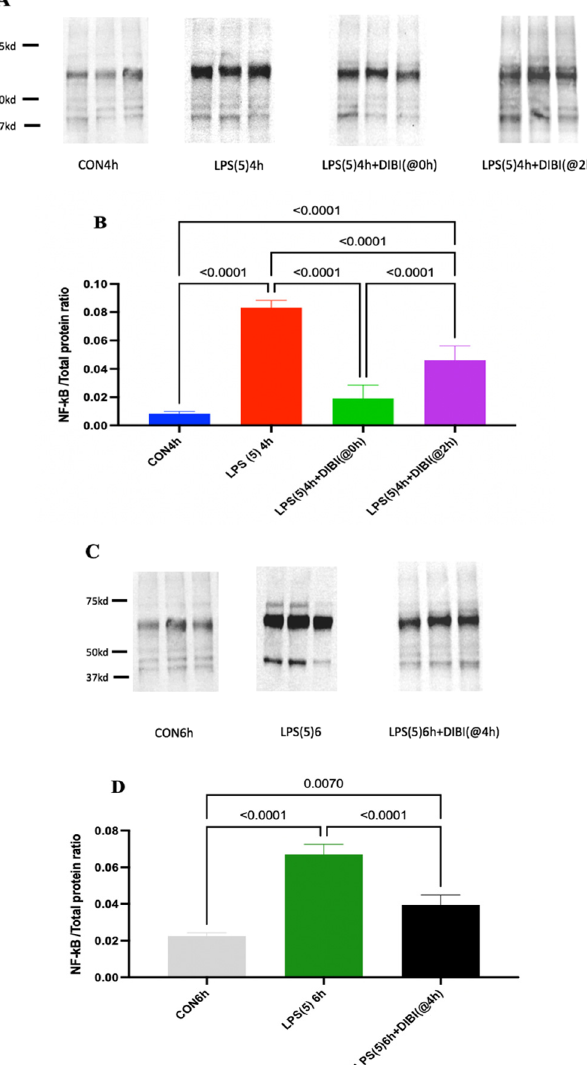
Figure 3. DIBI attenuated NF-kB activation in lung tissue following intranasal LPS challenge in mice. Phosphorylated NF-kB was detected using Western blotting with a specific anti-p65NFkB antibody. ( A , C ) Representative Western blot images. ( B , D ) Semi-quantification of NF-kB signal. Data are expressed as means ± SD for each group ( n = 5–9 mice per group), p values for significant differences are indicated on top of each comparison bars. Groups: CON4h—control group observed after 4 h;